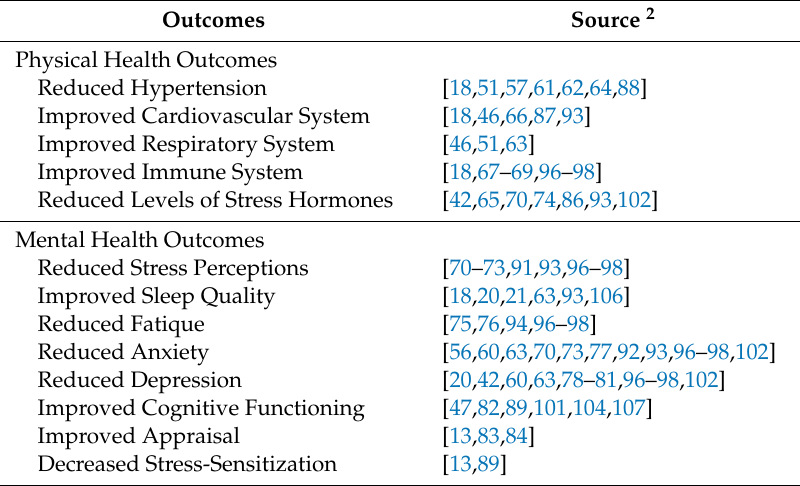
Table 1. Summary of Stress-Reducing Outcomes of Qigong and its Components 1